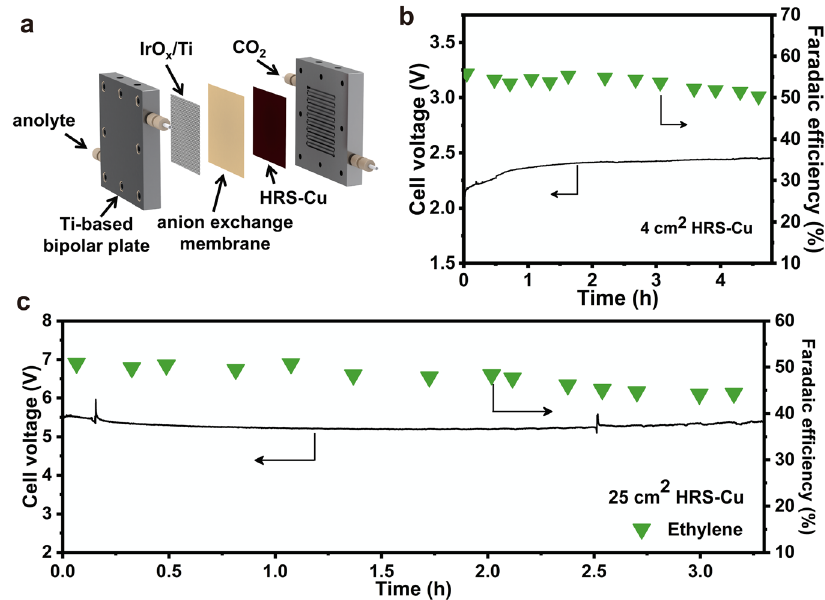
Fig. 5 Scaling up the CO 2 reduction system. a Schematic of the MEA system. The gaskets are not shown. b Stability test over a span of ~4.5 h of CO 2 - electrolysis in a 4 cm 2 -MEA system at the total current density of 120 mA cm − 2 . c Stability test over a span of ~3.5 h of CO 2 -electrolysis in a 25 cm 2 -MEA system at the total current of 12 A. The decrease in ethylene F.E. and the increase in cell voltage may be attributed to the formation of carbonate on the cathode side and the cathode water fl